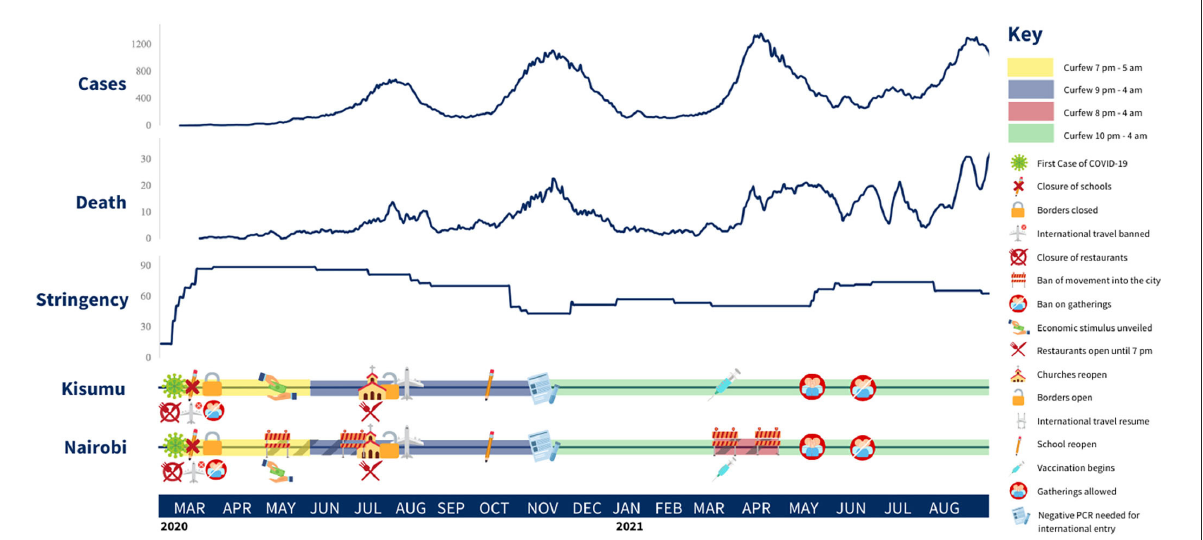
FIGURE1 Evolution of COVID-19 cases, deaths and policy. Sources: cases, deaths, and stringency data obtained from the COVID-19 Data Repository by the Center for Systems Science and Engineering (CSSE) at Johns Hopkins University. Policy information was obtained from the Kenyan Ministry of Health Kenya COVID-19 Situation Reports and from the Presidential Addresses on the Coronavirus Pandemic (Kenyatta, 2020, 2021; Ministry of Health, 2020a,b).